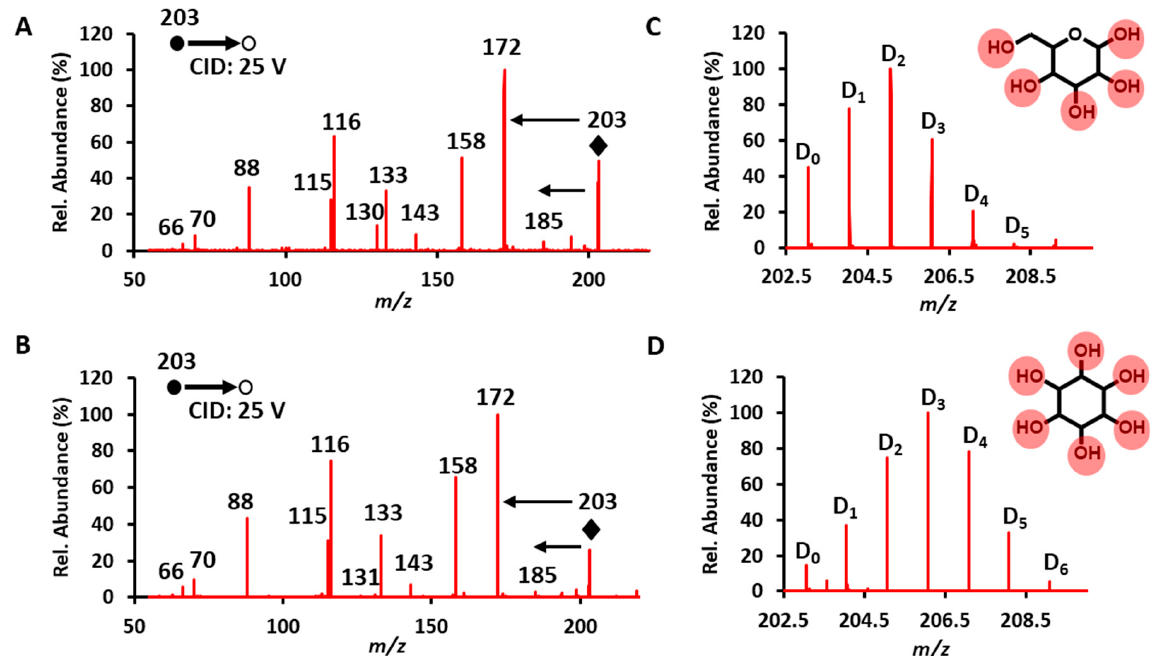
Figure 3. HDX for isobaric ions that also share similar MS2 patterns. CID-MS/MS spectra for ( A ) glucose and ( B ) inositol; post-HDX, high-resolution mass spectra for ( C ) glucose and ( D ) inositol. The diamonds denote the precursor ions, and circles in the diagrams identify exchangeable sites.